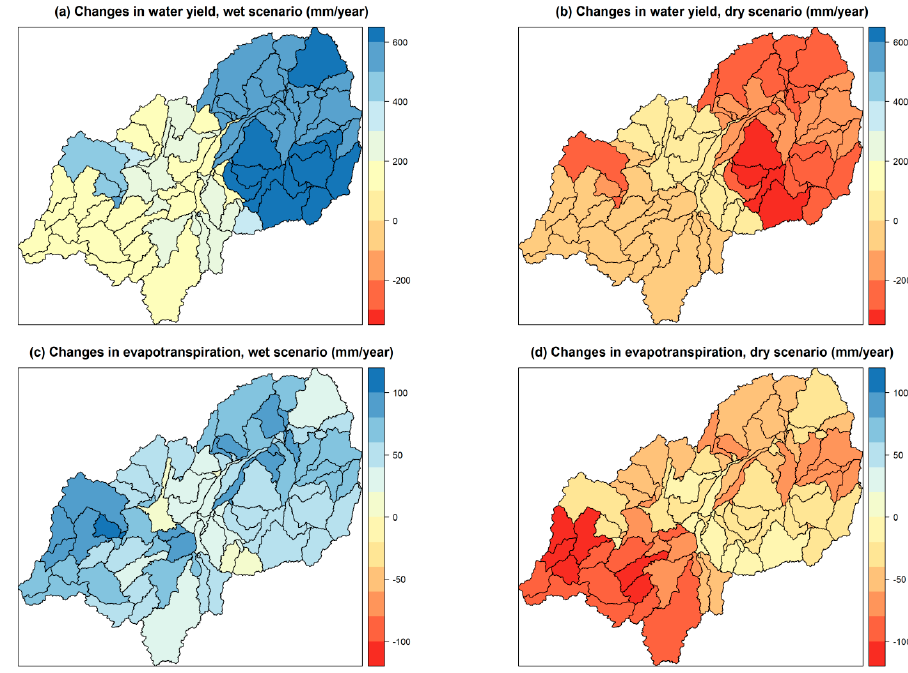
Figure 14. Average shifts in total water yield ( a , b ) and evapotranspiration ( c , d ) for the wettest and driest decade in comparison to their historical average (1951–2005). ( a , c ) Changes between the historical annual average of model 6 and the RCP8.5 scenario from 2040 to 2049 of model 6; ( b , d ) Changes between the annual historical average of model 2 and the RCP8.5 scenario from 2020 to 2029 of model 2.